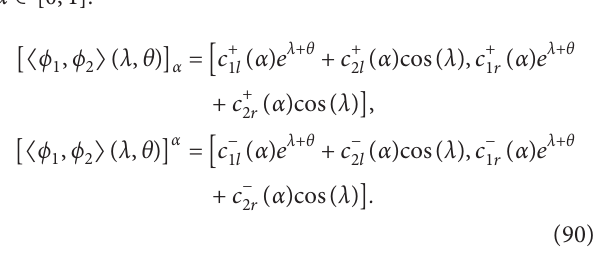
Figure 6: The surface of the intuitionistic fuzzy